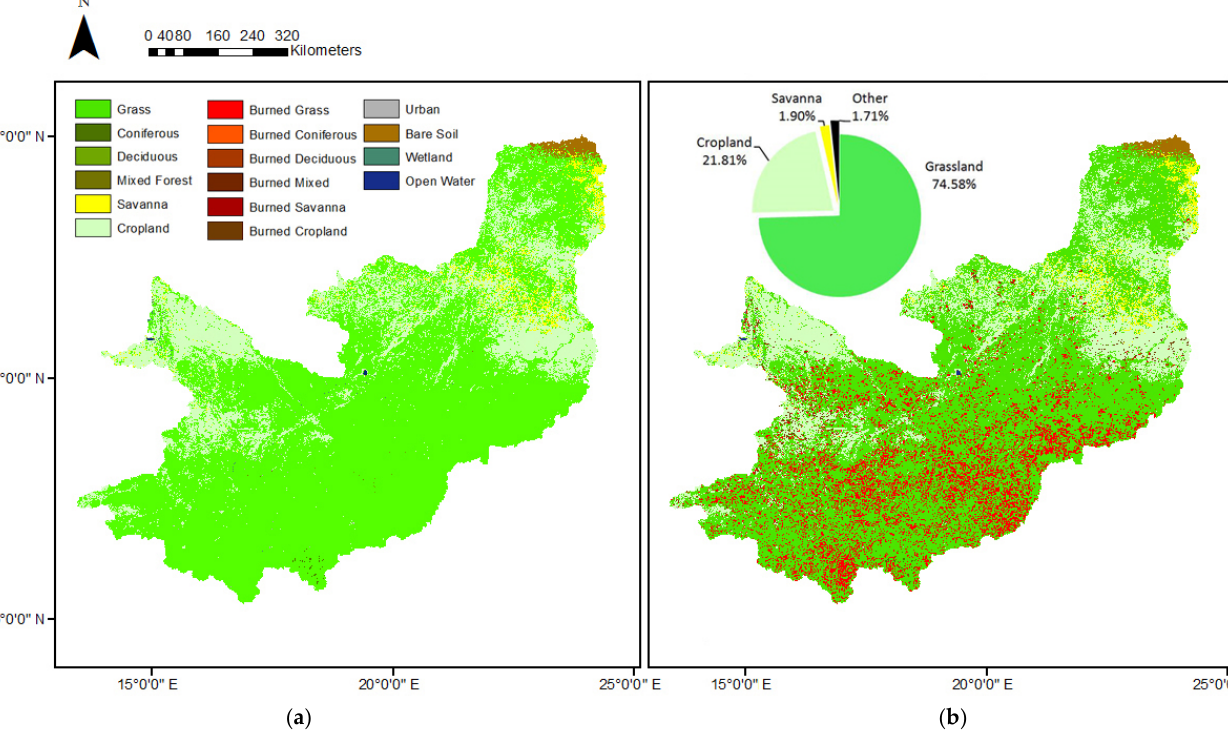
Figure 4. ( a ). Map showing August 2010 WetSpass-M land cover classifications derived from MODIS MDC12Q1. ( b ) Map showing January 2010 WetSpass-M land cover classifications derived from MODIS MDC12Q1 superimposed with fire detections (red dots) derived from MODIS MOD14. Pie chart shows land cover percentages in the Chari–Logone catchment area derived from MDC12Q1. Grassland is by far the greatest land cover type, followed by cropland. All other land cover types, such as forest, bare soil, wetland, urban, and open water, are combined into the category “other”.